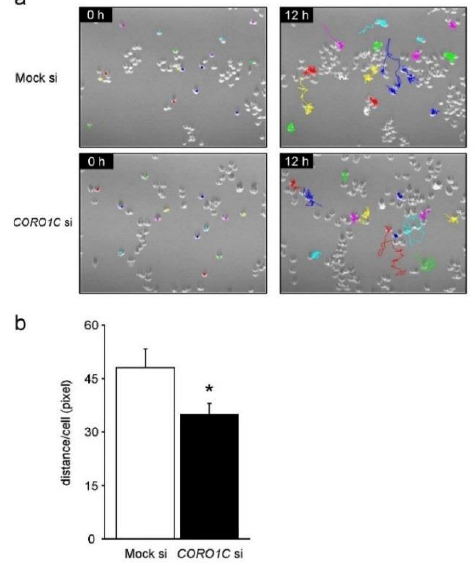
Figure 6. Migration of the mock and Coronin1C-knockdown RAW-D cells. ( a ) Mock and Coronin1C-knockdown RAW-D cells seeded onto a 6-well plate were analyzed by time-lapse video microscopy. Micrographs of time-lapse imaging showing cell tracks. Representative plots of approximately 15 cells of mock and Coronin1C-knockdown RAW-D cell migration tracks for a total duration of 12 h/track. The data and pictures are representative of three independent experiments. ( b ) The distance traveled between positions (path length) of 100 cells. * p < 0.05, compared with the mock cells. ( c ) Average migration speed of 100 cells * p < 0.05, compared with the mock cells.